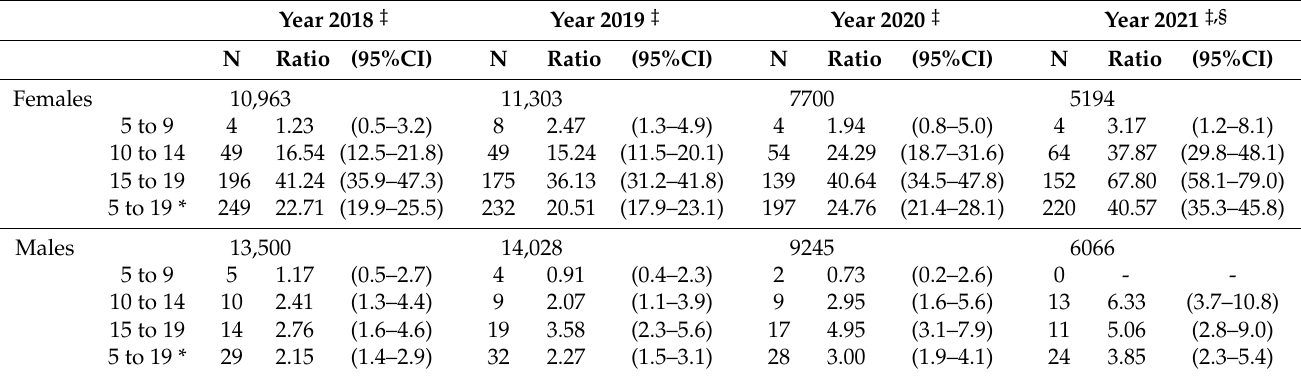
Table 1. Gender age-specific and age-adjusted (with 95% CIs) EDs ratio of hospital admissions per 1000 admissions, pre (years 2018 and 2019), during (2020) and post (2021) the pandemic peak; Pied- mont region, Italy.